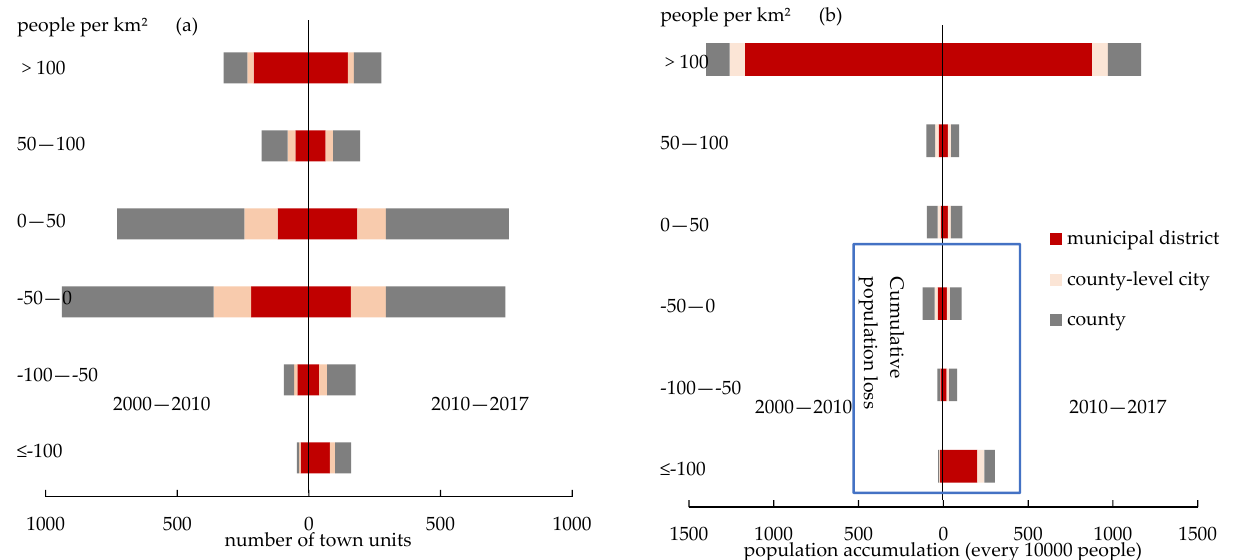
Figure 6. ( a ) Number of units at each level of population density change; ( b ) Population accumulation of population density change at all levels.